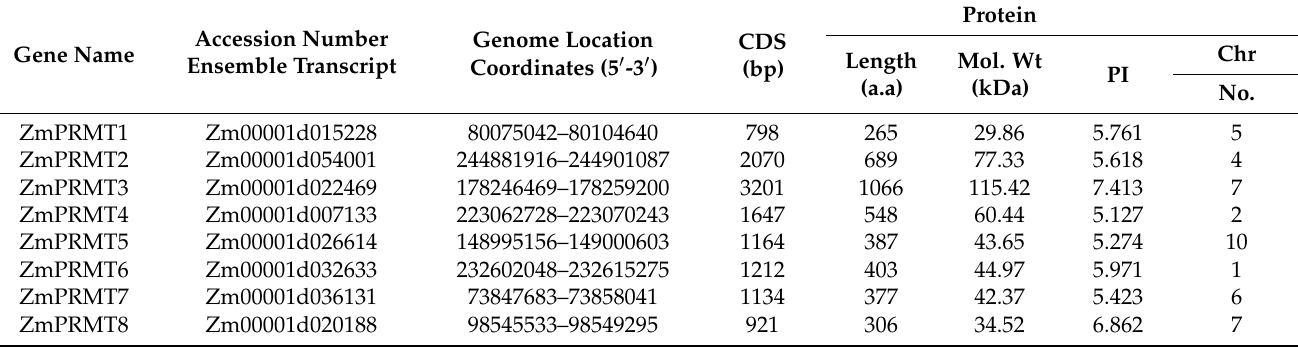
Table 1. Basic information about ZmPRMT in